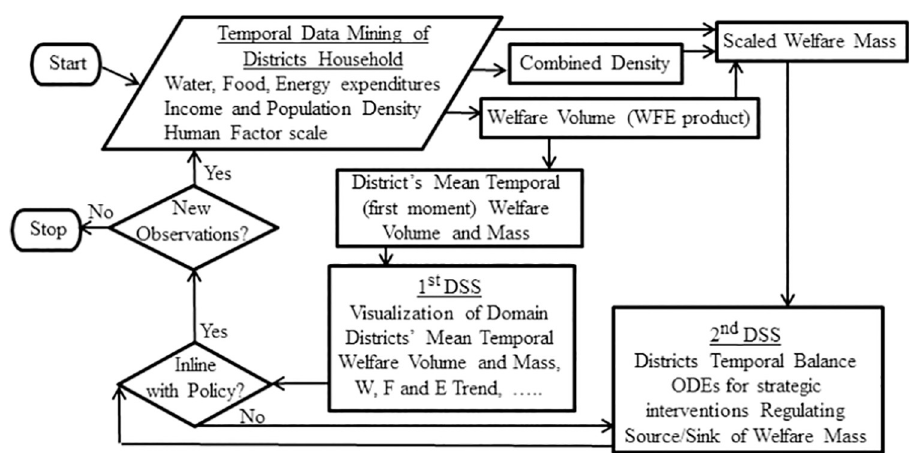
Fig 1. Flowchart of the macro management tool for WFE Nexus of geospatial administrative nodes (districts) with core aspects addressed by two DSS processes. The first for the “Realize” and “Why” phases and the second for the”How”